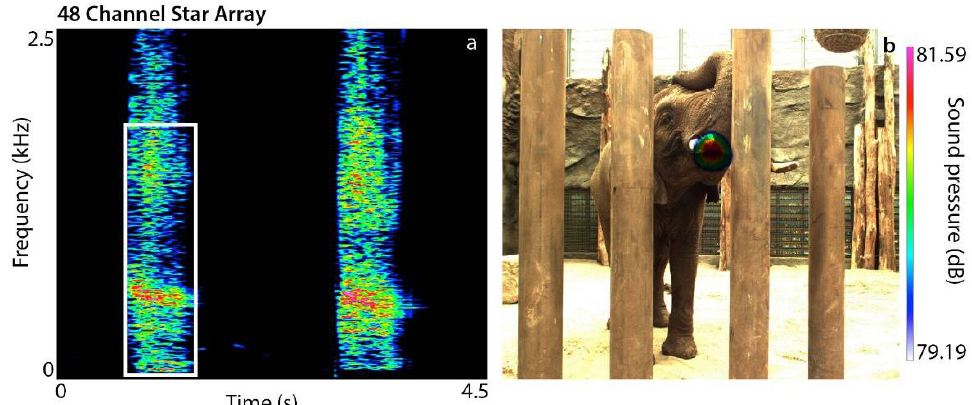
Figure 5. Structure and sound radiation of oral bursts. ( a ) Spectrogram and ( b ) sound visualization of an oral burst